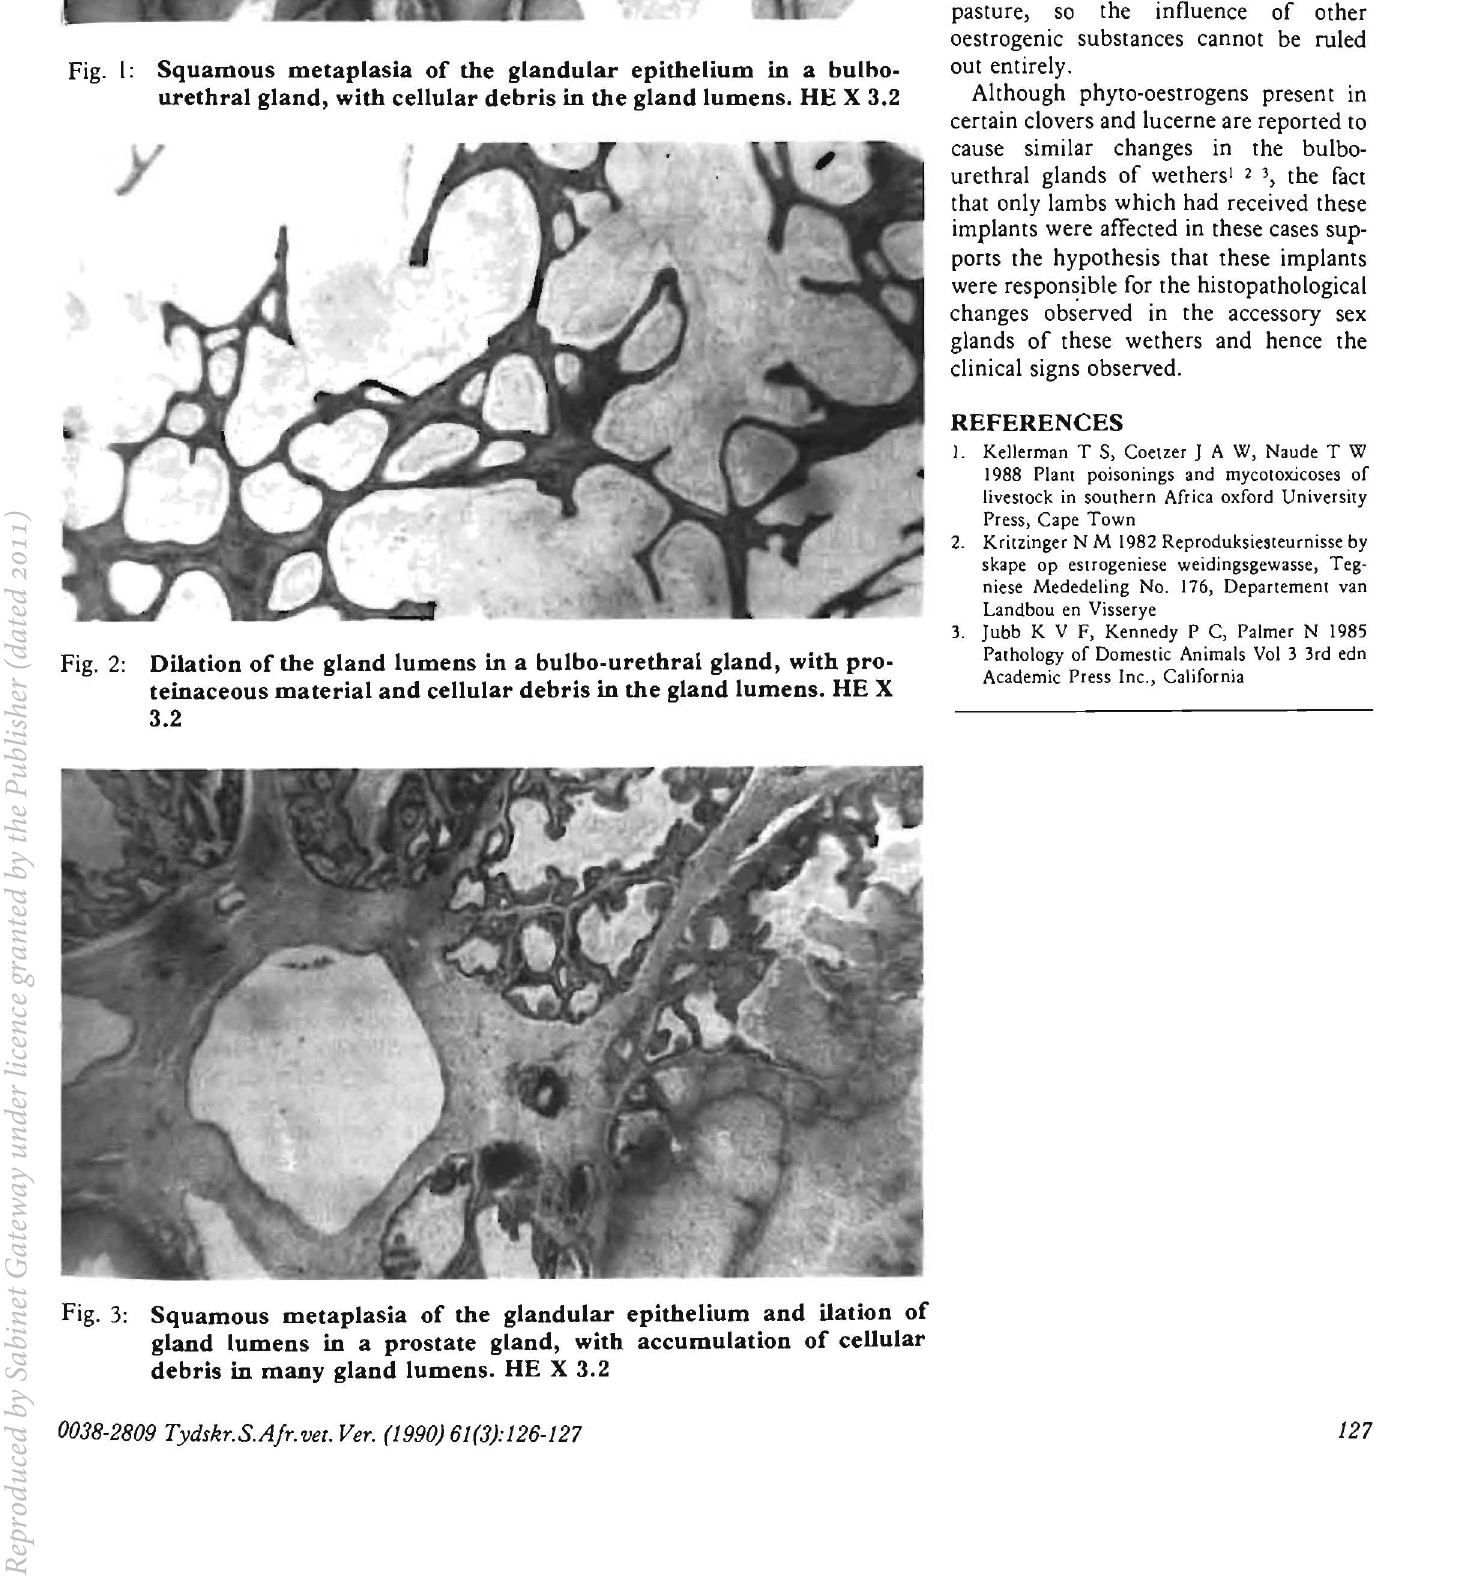
Fig. I: Squamous metaplasia of the glandular epithelium in a bulbo urethral gland, with cellular debris in the gland lumens. HE X 3.2